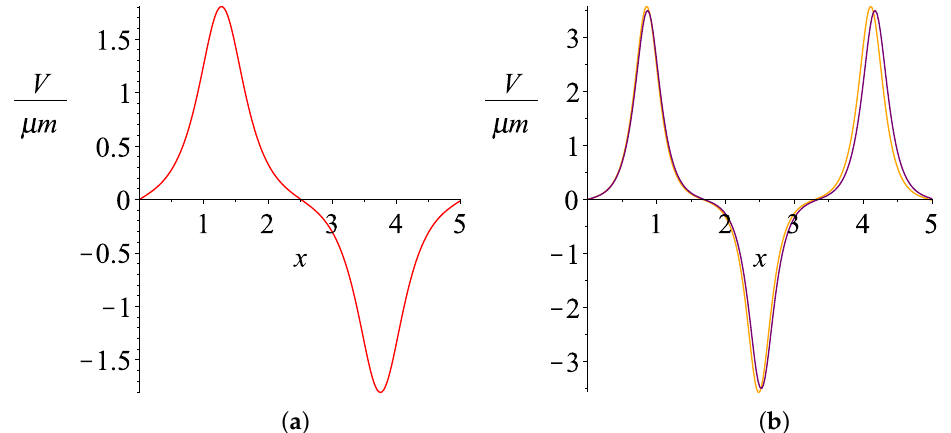
β Figure 11. Subfigure ( a ): the eigenmode of problem α (red curve) corresponding to the propagation P constant denoted by the red diamonds in Figure 9. Subfigure ( b ): the eigenmodes of problems (purple curve) and (orange curve) corresponding to the propagation constants denoted by the P α purple and orange diamonds in Figure 9.